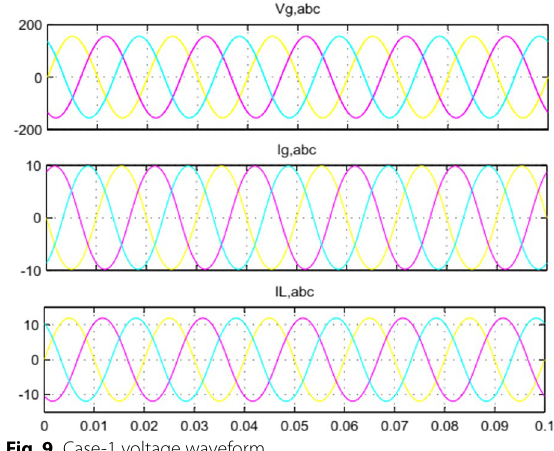
Fig. 9 Case-1 voltage